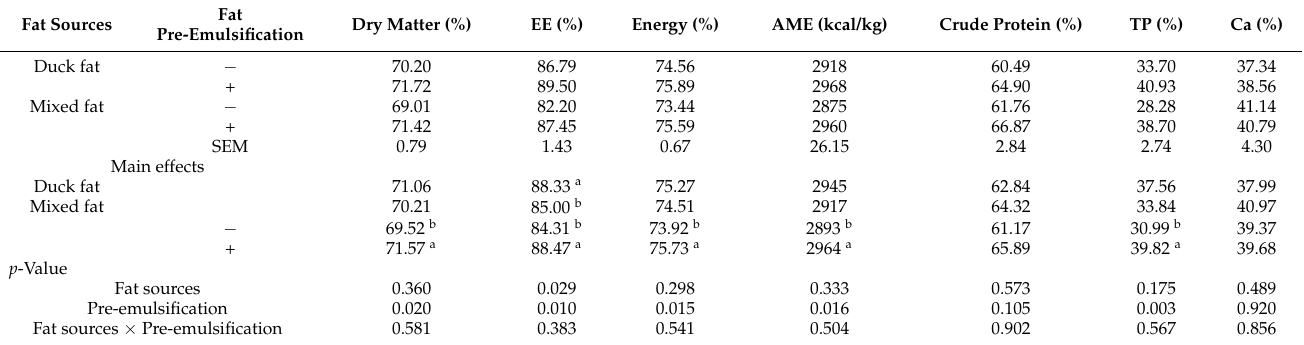
Table 6. Effects of fat sources and pre-emulsification on nutrients and energy utilization of ducks 1,2 .